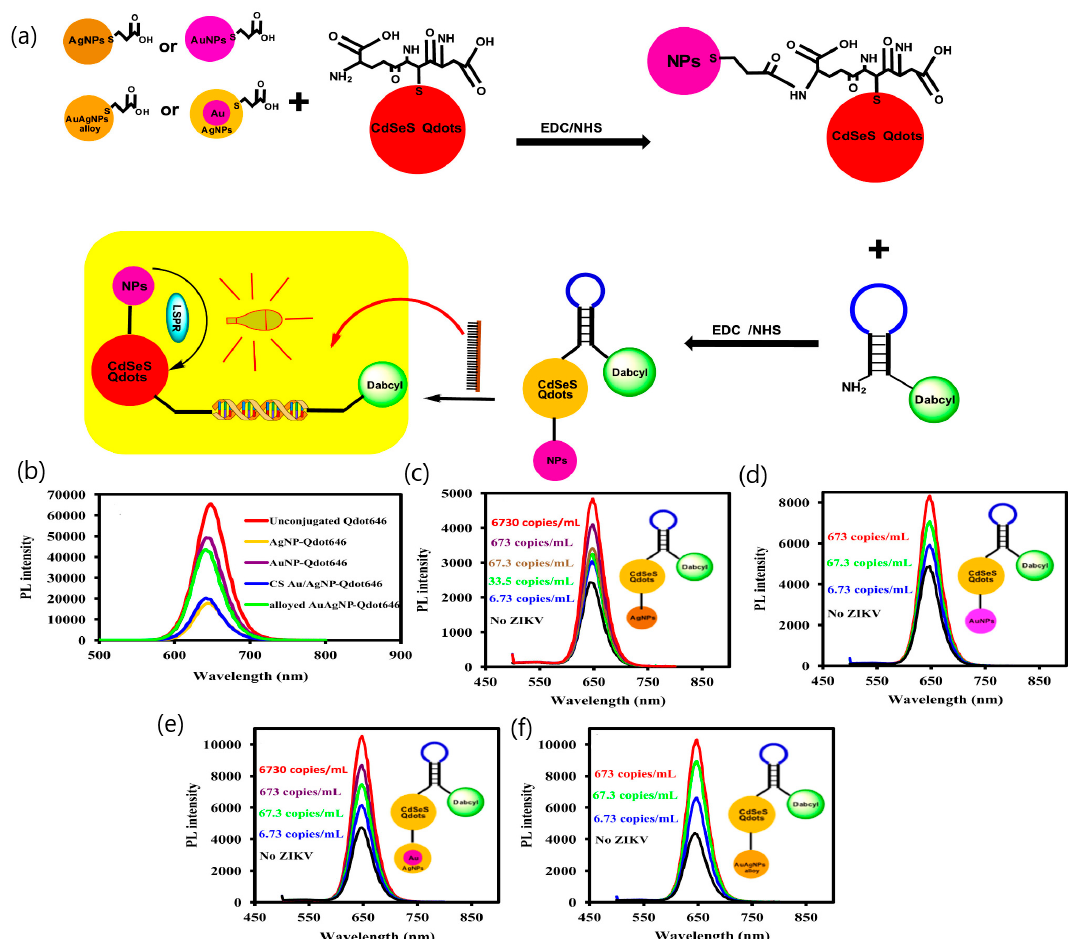
Figure 9. ( a ) Illustration of the conjugation of NPs to GSH (glutathione)-CdSeS QDs (Qdot646) to form the plasmonic NP-QDs’ nanohybrids. The subsequent conjugation of the plasmonic NP-QDs to the MB to form the plasmonic NP-QDs-MB biosensor probe and the LSPR-mediated fluorescence signal detection of the Zika virus based on hybridization of the RNA with the DNA loop sequence of the MB. ( b ) Fluorescence-quenching effect of the plasmonic NPs on the fluorescence of Qdot646 particles. ( c – f ) LSPR-mediated fluorescence enhancement of Zika virus RNA using the plasmonic NP-QDs-MB biosensor probe: ( c ) AgNP-Qdot646-MB, ( d ) AuNP-Qdot646-MB, ( e ) CS Au/AgNP-Qdot646-MB (molecular beacon), and ( f ) alloyed AuAgNP-Qdot646-MB. Inset: Structure of the plasmonic NP-QD-MB biosensor probe. The fluorescence measurement was carried out in the wavelength range of 480–800 nm with an excitation wavelength of 470 nm. The hybridization time was set at 3 minutes. Adapted with permission from Adegoke et al. [49] Copyright © (2017) Elsevier.